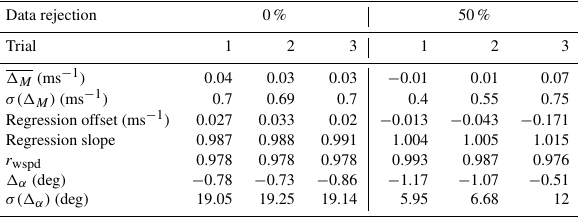
Table 2. Results of the comparison between the lidar-derived winds and the sonic anemometers on the BAO tower. The results with 0 and 50% data rejection are shown. The averaging times for the sonic anemometer data were twice the PPI scan duration, or nomi- nally about